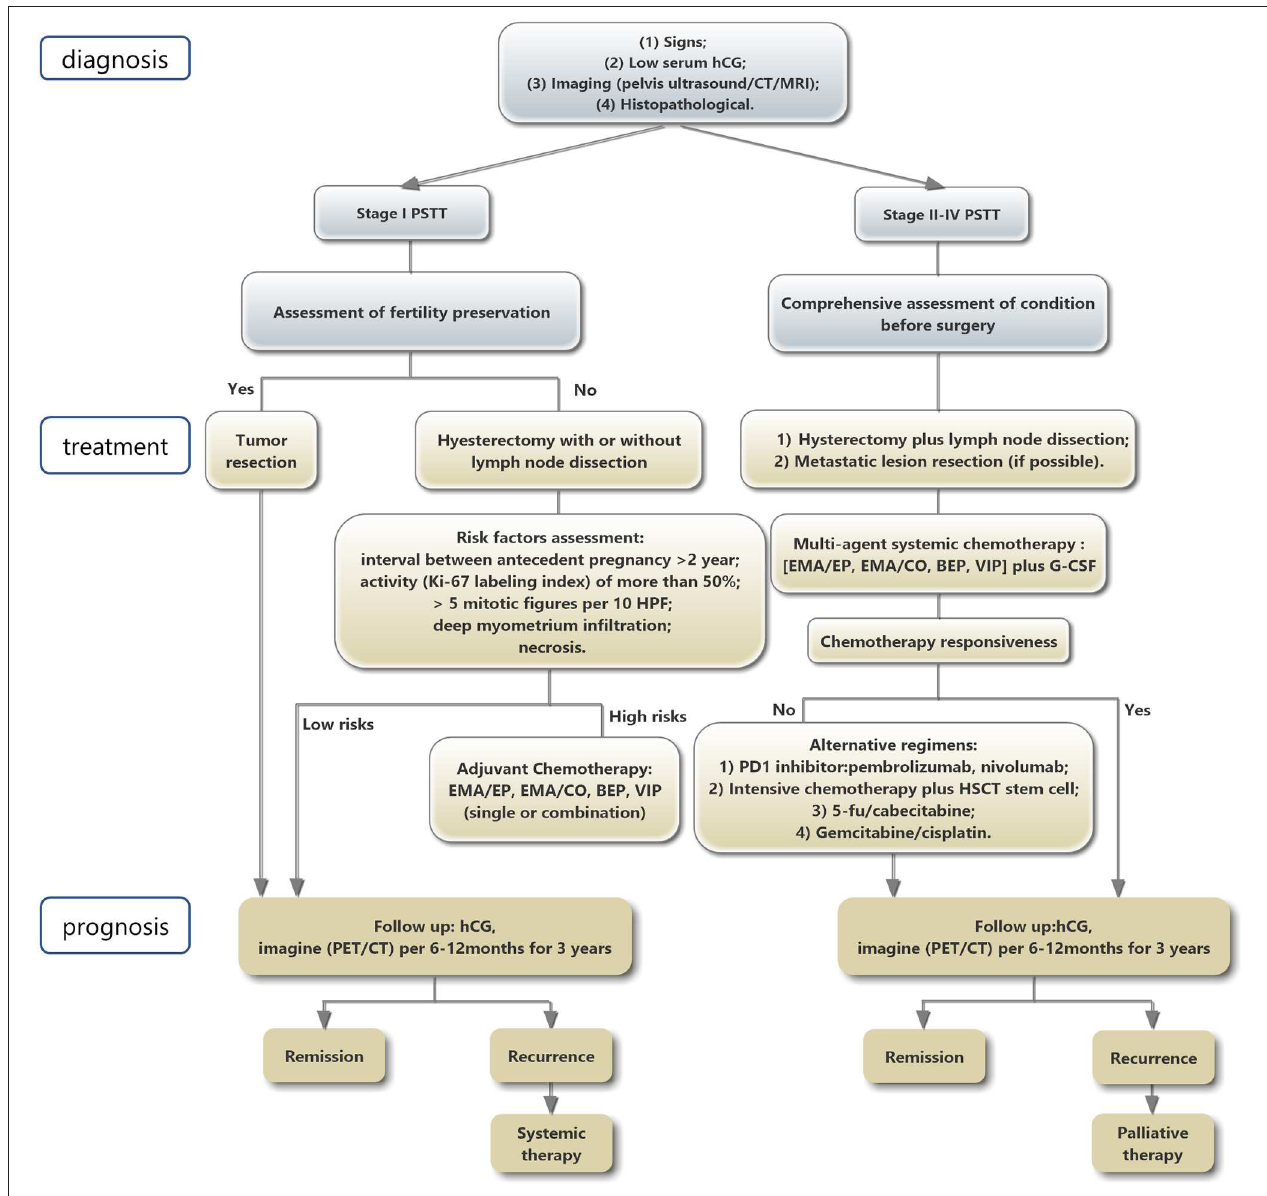
FIGURE 5 | Schematic presentation of PSTT diagnosis, treatment, and